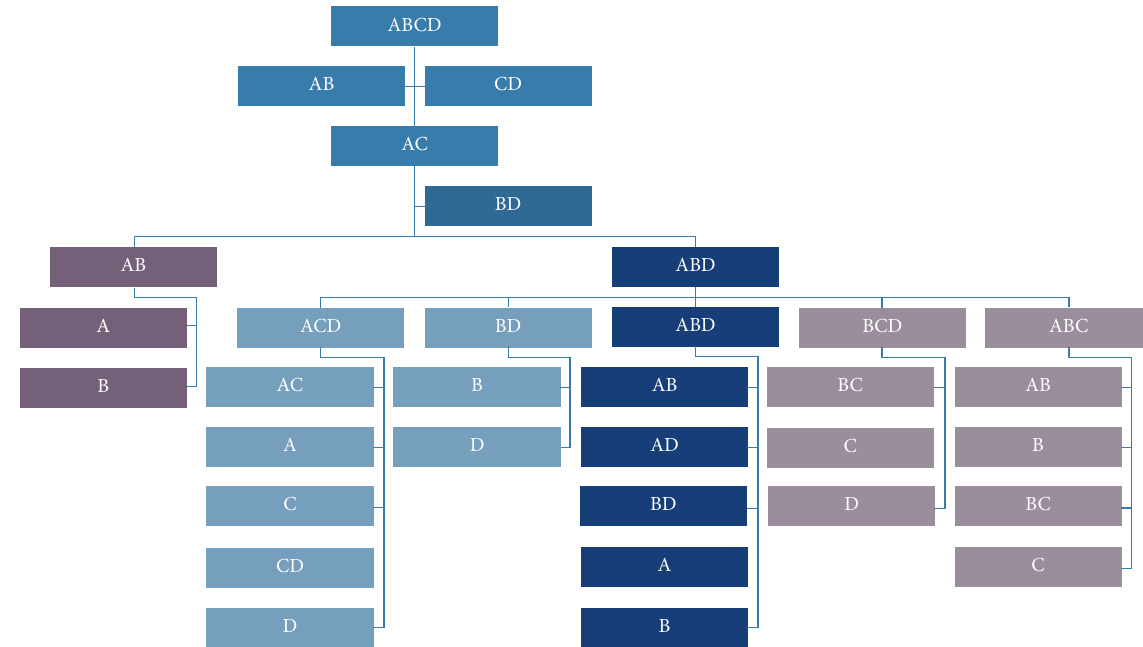
Figure 6: A performance evaluation model based on decision tree C4.5